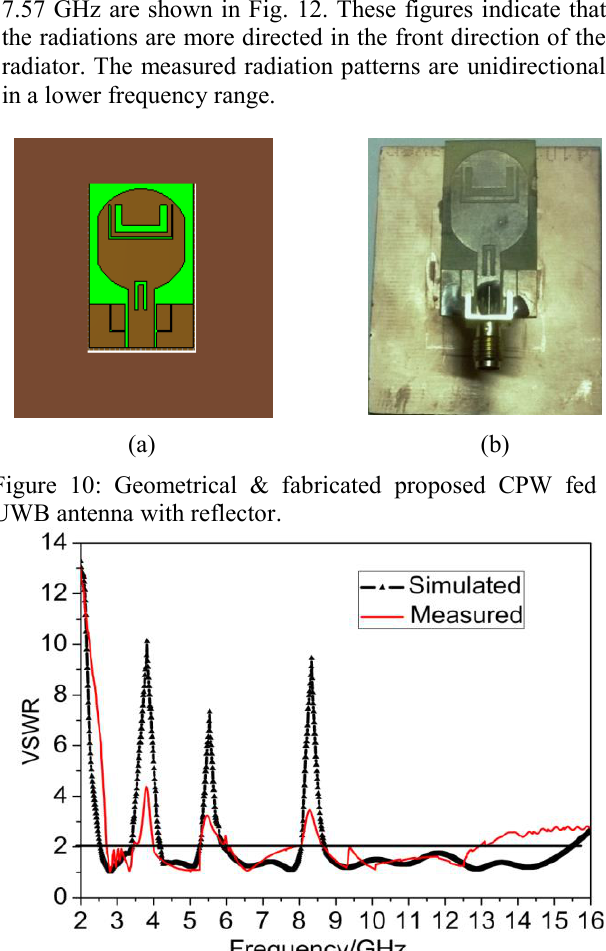
Figure 11: Measured and simulated VSWR of the proposed UWB antenna with